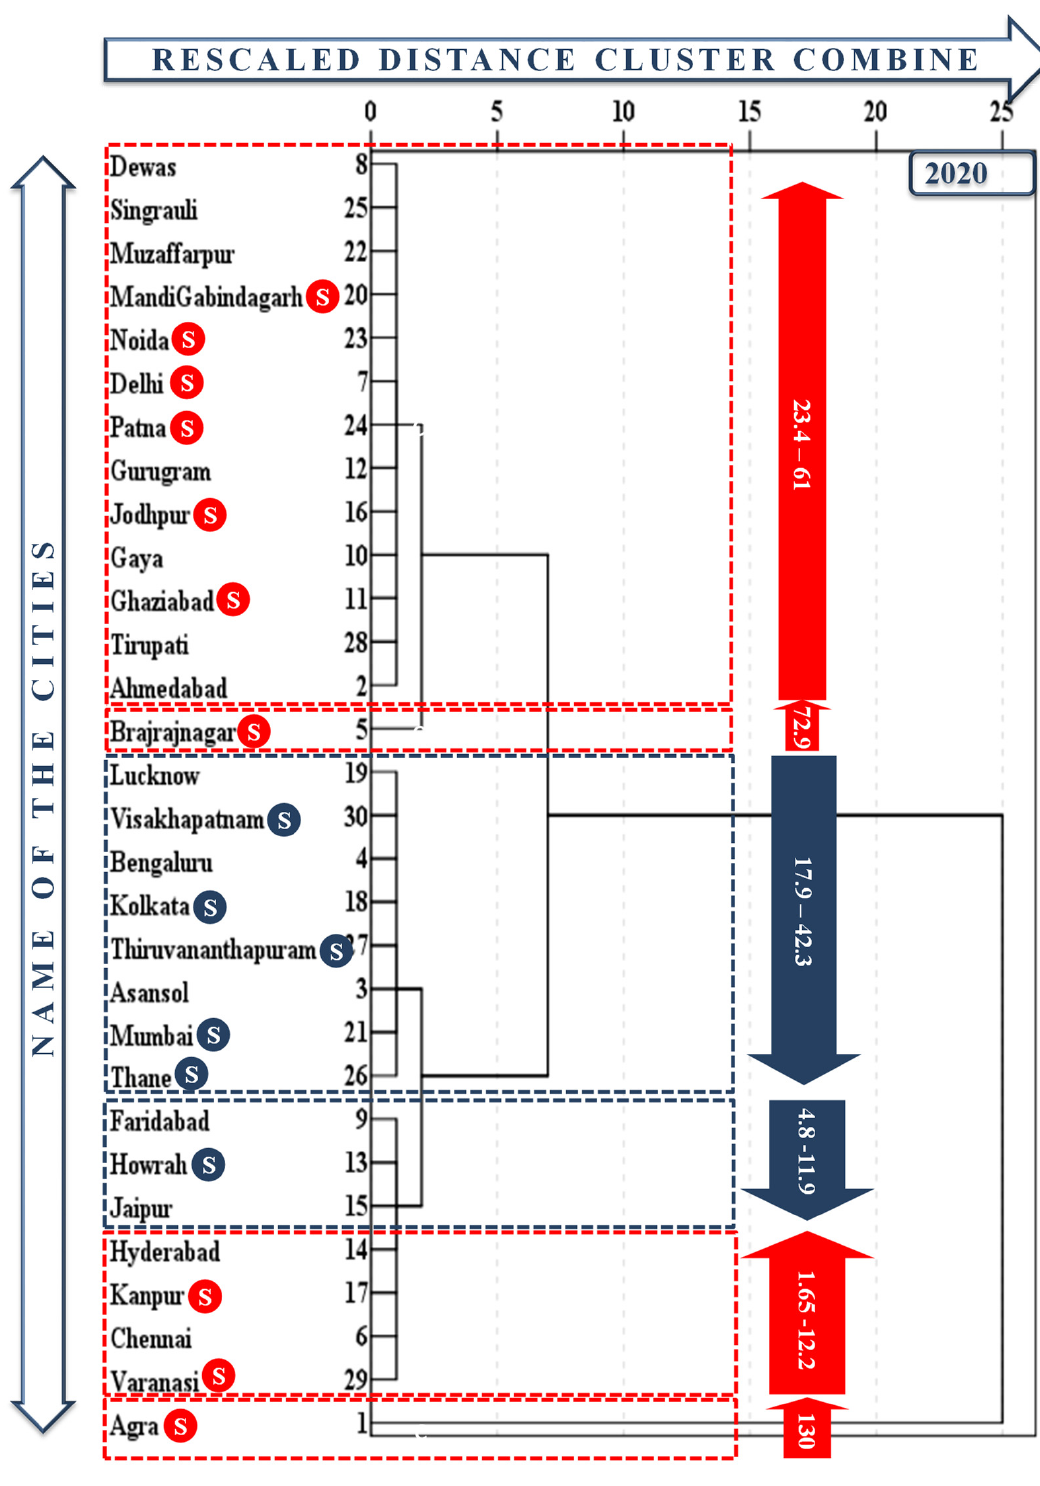
Figure 3. Clustering of cities based on the percentage change in mean O 3 concentrations during the second phase/lockdown, as compared to the first phase/pre-lockdown of 2020 for 30 selected Indian cities. Clustering cities with red and blue color boxes show increasing and decreasing O 3 concentrations; cities with similar increasing and decreasing of O 3 concentrations during 2018, 2019, and 2020 are marked as similar (S) in a red and blue color circle.